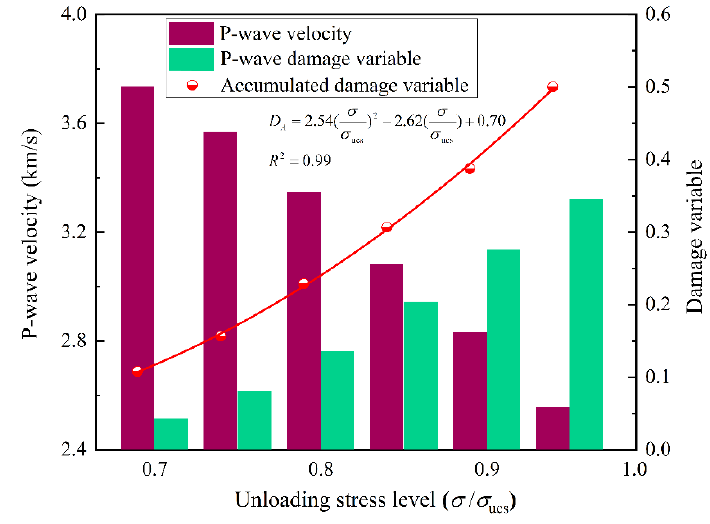
Figure 8. Variation in the P-wave velocity and damage variables.